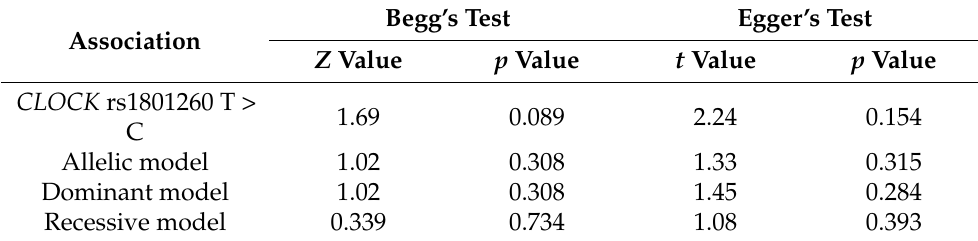
Table 4. Publication bias was assessed by Begg’s and Egger’s